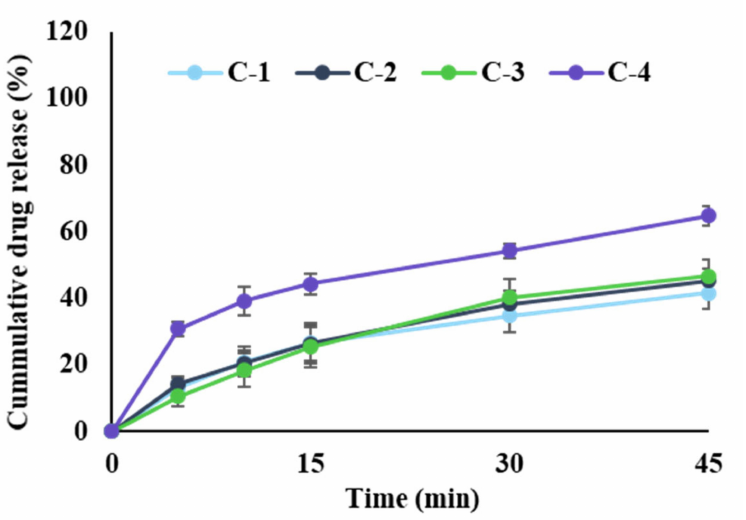
Figure 3. The release profile of EMP mini-tablet core (mean ± standard deviation, n =